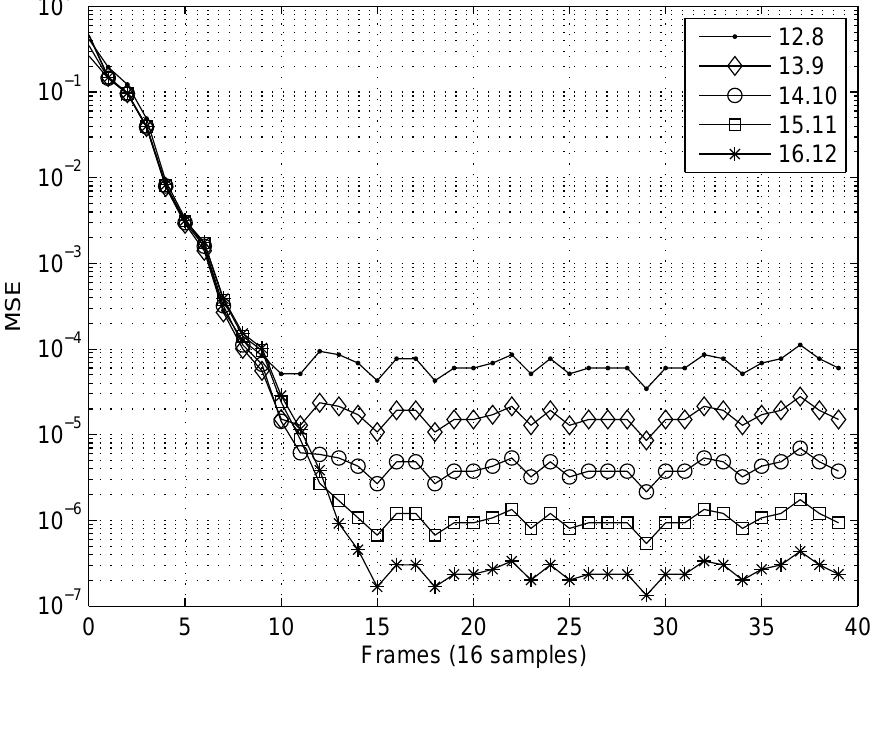
Figure 7. Performance of the RBF in tests using the XOR gate